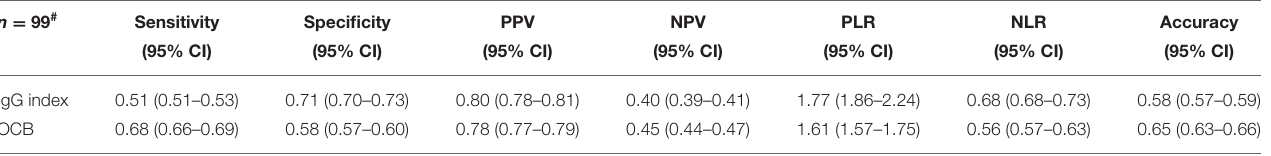
TABLE 2 | Diagnostic performance of IgG index and OCB.